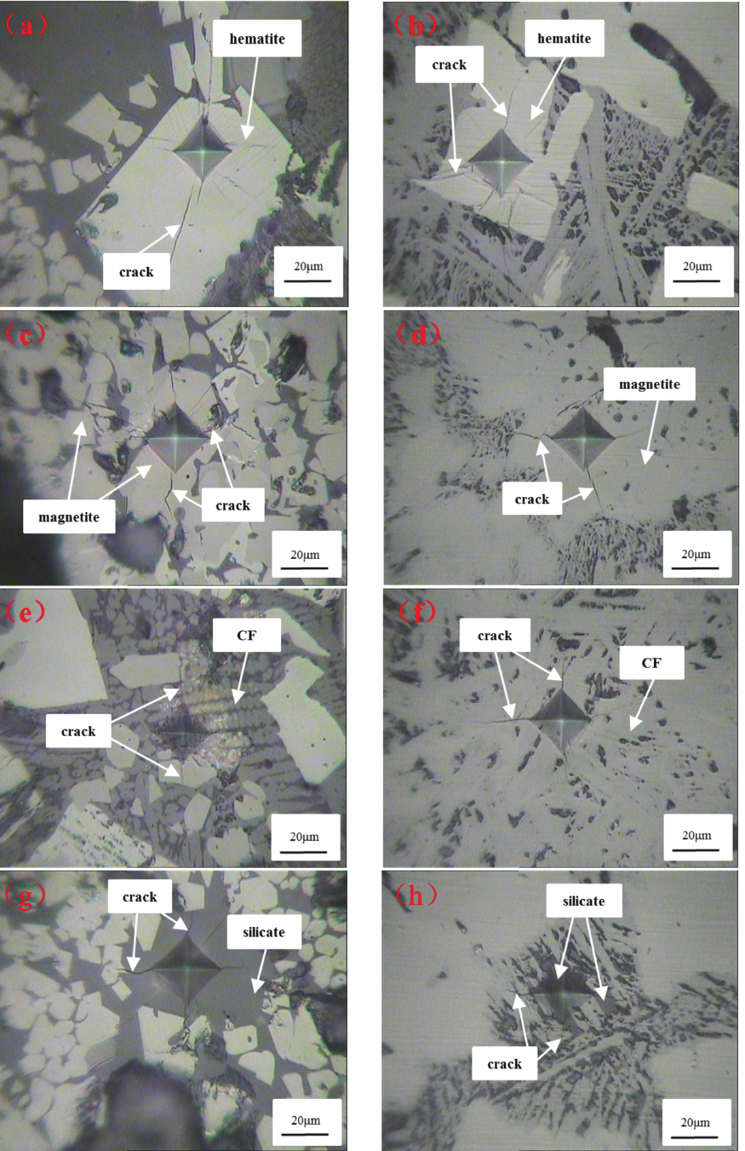
Figure 11: Indentations of different minerals in the two sinters. (a), (c), (e), and (g) represent the minerals in vanadium-titanium sinter; (b), (d), (f),and (h) represent the minerals in traditional